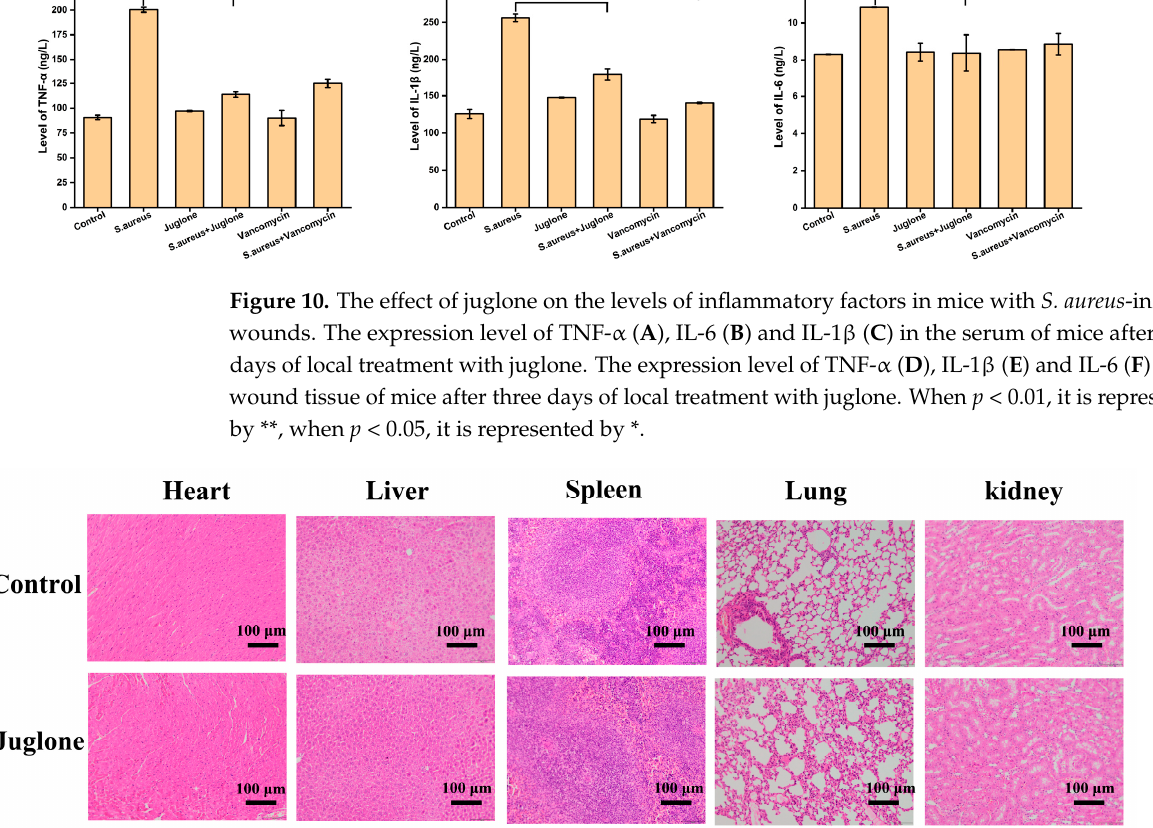
Figure 11. Safety assessment of juglone. The effect of juglone on the main organs (heart, liver, spleen, lung and kidney) of mice after 14 d of topical treatment. Scale bar was 100 μ m.